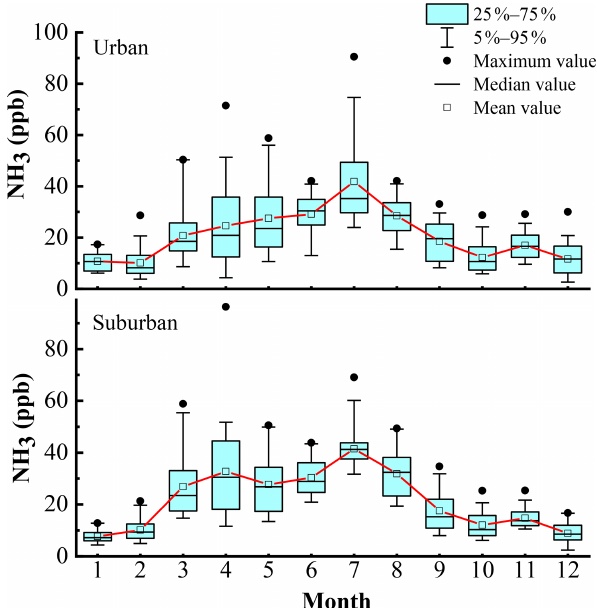
Figure 3. Monthly statistical variation in the NH 3 mixing ratios at the urban and suburban sites in